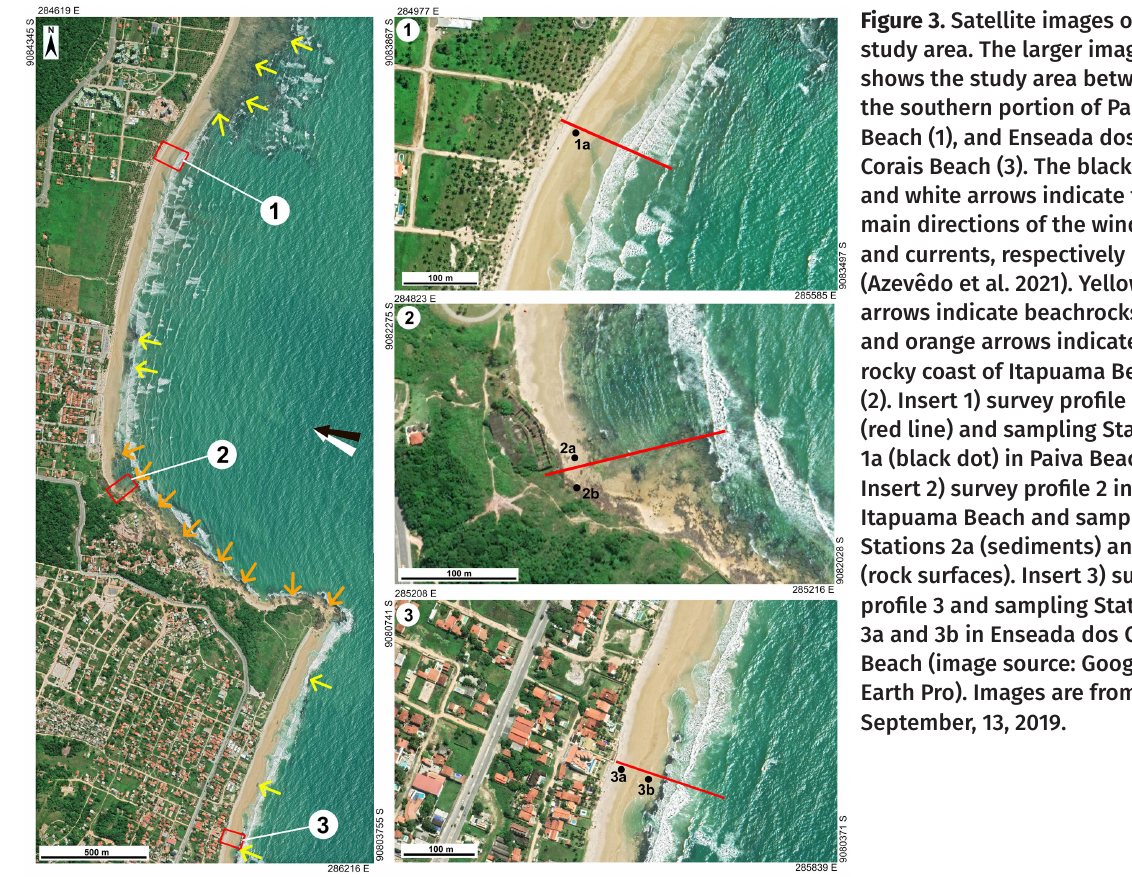
Figure 3. Satellite images of the study area. The larger image shows the study area between the southern portion of Paiva Beach (1), and Enseada dos Corais Beach (3). The black and white arrows indicate the main directions of the winds and currents, respectively (Azevêdo et al. 2021). Yellow arrows indicate beachrocks and orange arrows indicate the rocky coast of Itapuama Beach (2). Insert 1) survey profile 1 (red line) and sampling Station 1a (black dot) in Paiva Beach. Insert 2) survey profile 2